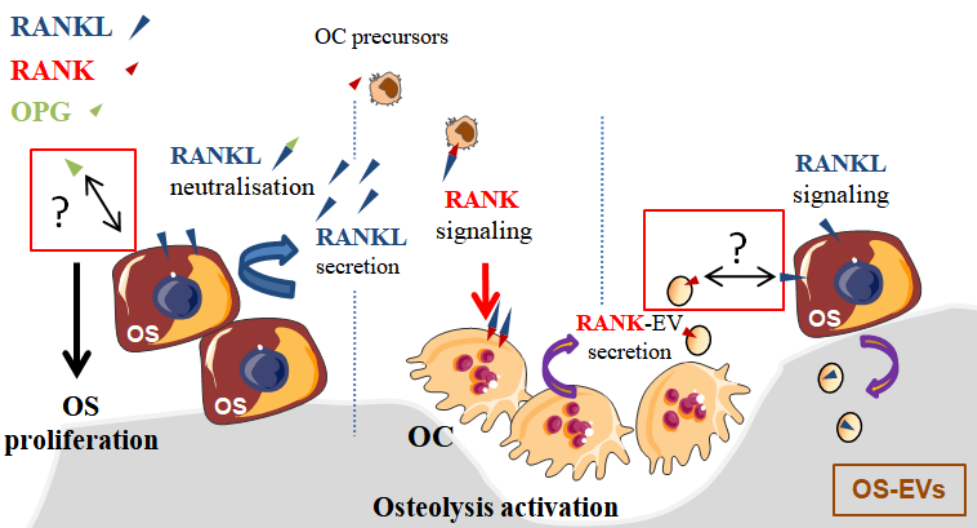
Figure 2. Proposed model of OPG/RANK – RANKL interactions in osteosarcoma (OS). RANK transduction induces the differentiation of osteoclasts (OC), leading to osteolysis, which in turn activates tumor cell proliferation, described as the vicious cycle. OPG is a decoy form of RANK, binding and neutralizing RANKL. Additionally, OPG increases proliferation of RANKL-expressing OS cells following its binding to an unknown receptor [38], possibly RANKL. The reverse signaling of RANKL, described recently in osteoblasts [32], could be also induced in OS cells. To the same extend, OS cells expressing RANKL could be activated by RANK-extracellular vesicles (EVs) produced by OC. RANK: receptor activator of nuclear factor kappa-B; RANKL: RANK ligand; OPG: osteoprotegerin.